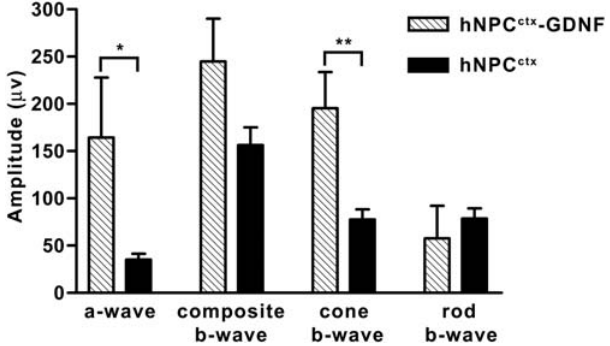
Figure 2. The capacity of human neural progenitors to preserve retinal function is augmented by GDNF expression. ERG response amplitudes to full field light stimulation were recorded at approximately P100 in RCS rats injected with hNPC ctx –GDNF ( n =9), hNPC ctx ( n =21) or medium alone ( n =3) into the subretinal space. Individual components of the ERG waveform (a-wave, composite b-wave, cone b-wave and rod b- wave) reveal relative contributions of different retinal cells to the overall functional activity of the retina. Cone b-waves were delineated by a double flash protocol and the rod-attributable b-wave was derived by subtraction from the composite level. Eyes injected with hNPC ctx –GDNF demonstrated significantly greater a-wave and cone b-wave amplitudes than those receiving hNPC ctx (* p , 0.05; ** p , 0.01; Student’s unpaired t - test). In contrast, the composite b-wave and rod b-wave amplitudes were not statistically different between the two groups. Control eyes injected with medium alone (sham-operated eyes) had no recordable ERG waves and are not included in the graph. Data are expressed as